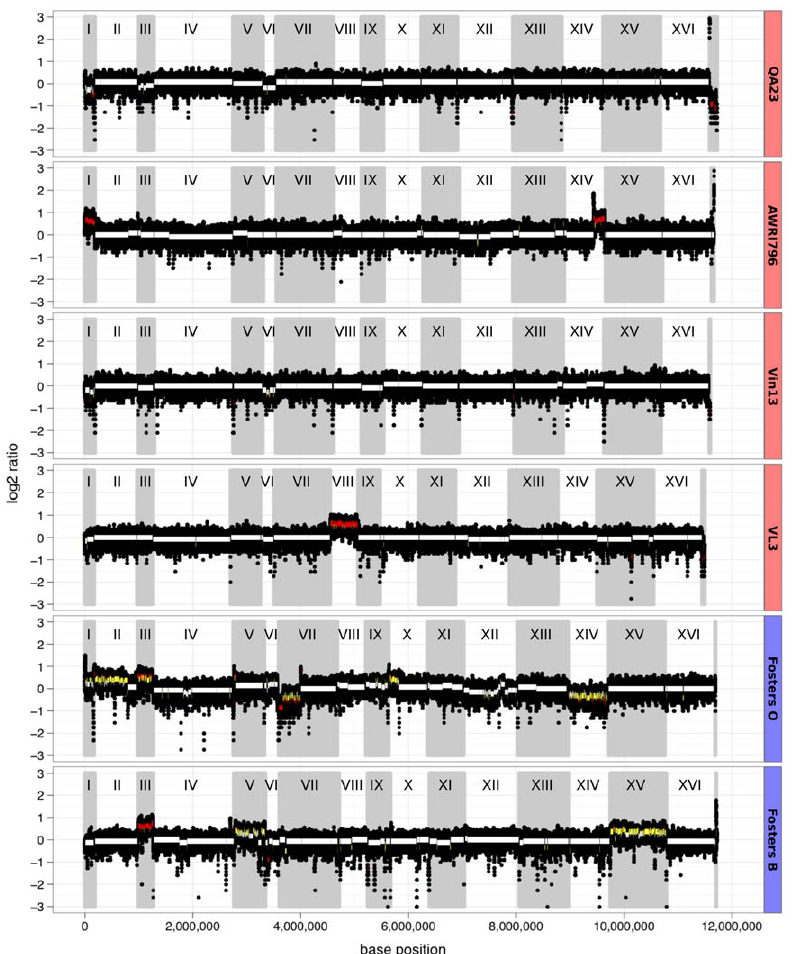
Figure 1. Chromosomal aneuploidy determined by whole-genome sequencing coverage. Sequencing coverage was determined for each contig using a sliding window of 1001 bp, with a 100 bp step frequency and plotted in chromosomal order (black circles). Regions of copy number variation were scored as either being greater than 1.25-fold (yellow lines; approximating either three or five copies in a tetraploid genome) or 1.5-fold (red lines; one or three copies in a diploid genome) different to the median coverage for that strain. Strains are shaded according to their industry (wine, red; ale, blue). doi:10.1371/journal.pgen.1001287.g001 PLoS Genetics |